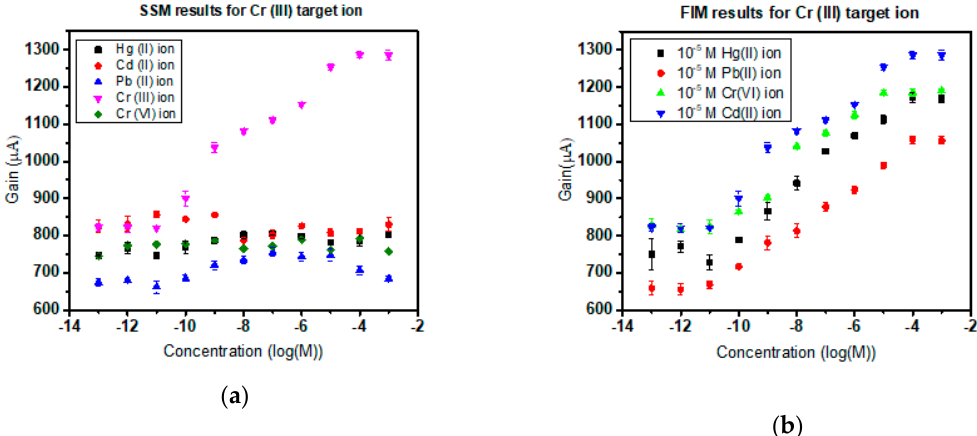
Figure 7. ( a ) Separate solution method of selectivity of Cr(III) ISMFET and its sensor response to other cations; ( b ) Finite Interference method selectivity curve of Cr(III) specific sensor in an environment of interfering cations.